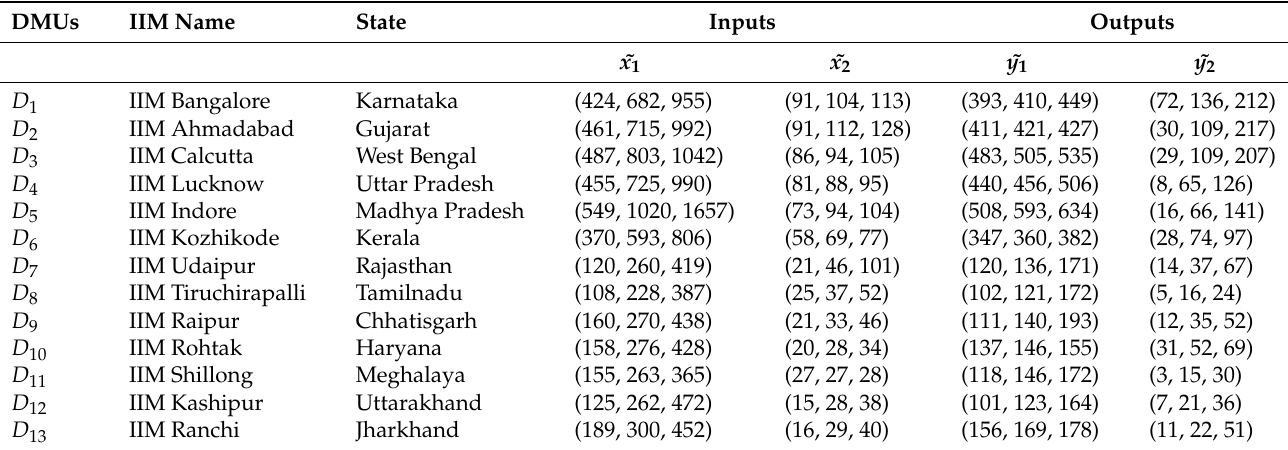
Table 5. Fuzzy input and output data for IIMs.